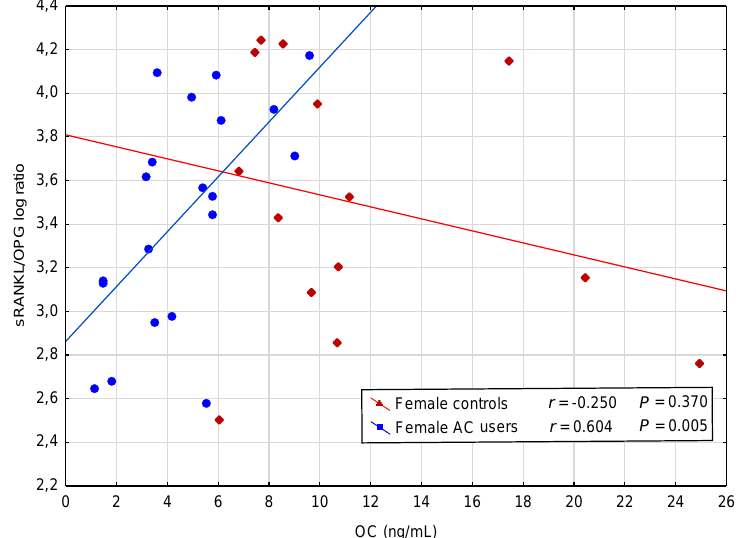
Figure 2. A positive correlation between concentration of osteocalcin (OC) and soluble receptor activator of nuclear factor-κB ligand (sRANKL)/osteoprotegerin (OPG) logarithm (log) ratio in female acenocoumarol (AC) users.